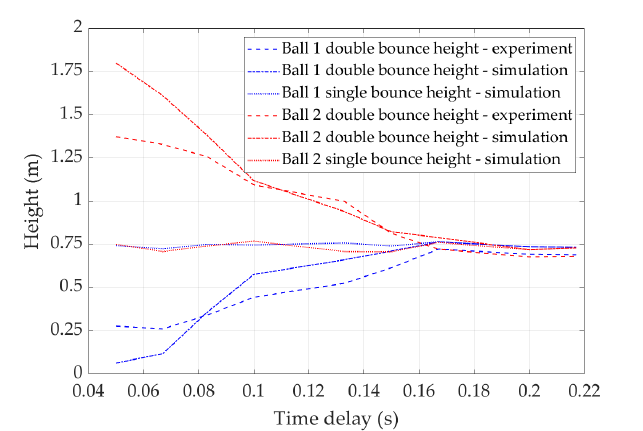
Figure 13. Bounce height of balls with different release time